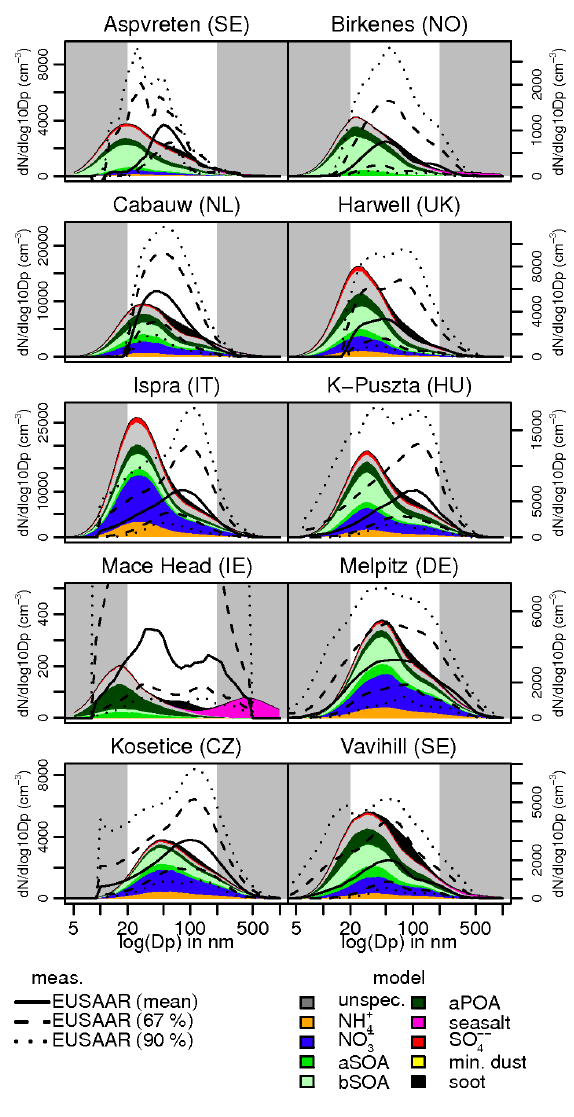
Fig. 11. Modelled and measured aerosol size distributions at EUSAAR stations for the autumn 2008 period. Modelled distributions are shown as area shaded by mass contributions of different species, calculated as median over the simulation period. Measured values are a statistical size distribution from data of the whole season and are shown as lines. Solid lines depict median values, dashed lines the 67% and dotted lines the 90% percentile range. Grey background denotes areas with higher measurement uncertainty (Wiedensohler et al., 2010).